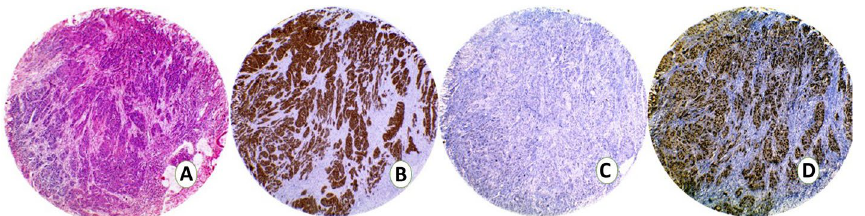
Fig. 5 TMA sections from a UC case assigned as basal subtype showing. A : H&E B :CK5/6 positive. C : GATA3 negative. D : Diffuse nuclear p53